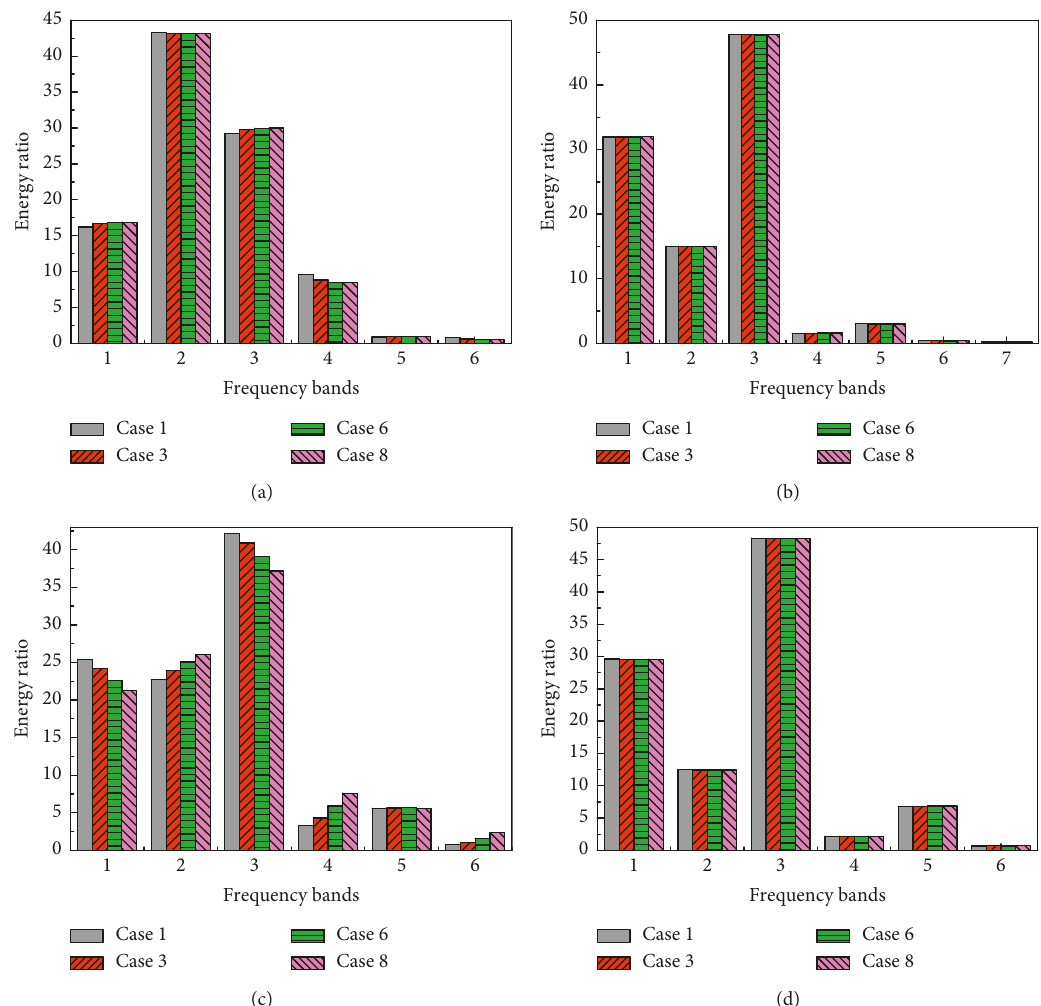
Figure 9: Hilbert feature vector spectrum in model tests (single damage). (a) Point 1. (b) Point 7. (c) Point 12. (d) Point